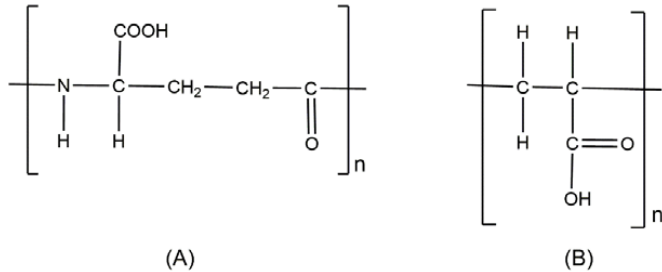
Figure 10. Chemical structures of ( A ) Poly( γ -glutamic acid) and ( B ) Poly(acrylic acid).